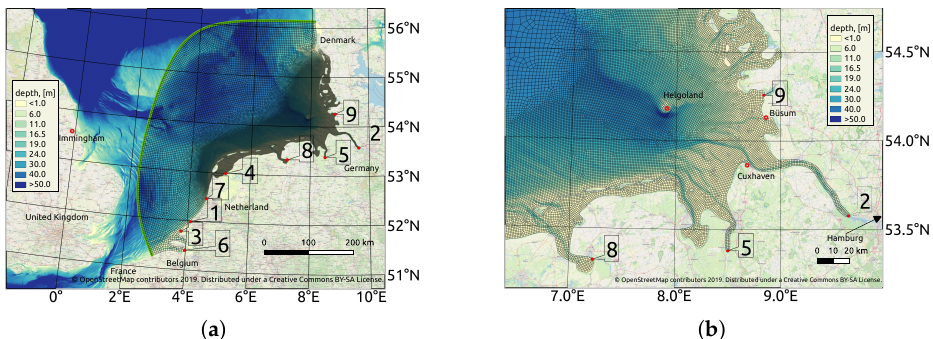
Figure 1. Bathymetry of the southern North Sea (colored contours, data from EMODnet Bathymetry portal); black lines show the mesh used for the five-year run: ( a ) a full domain; and ( b ) a zoom-in to the Cuxhaven–Helgoland area (the southeastern part of the full mesh). The background map was created with openstreetmap.org ( c (cid:13) OpenStreetMap contributors 2019. Distributed under a Creative Commons BY-SA